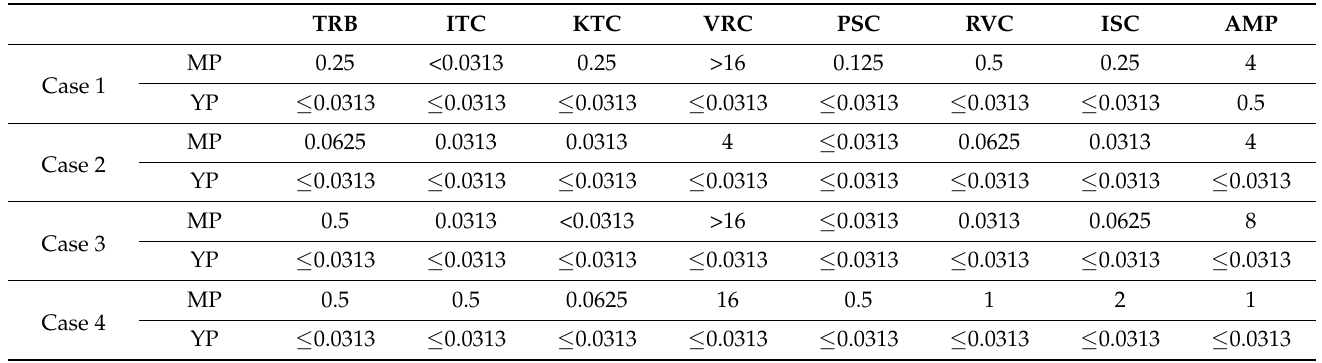
Table 1. MIC in µ g/mL for eight antifungal agents in both the mycelial and yeast